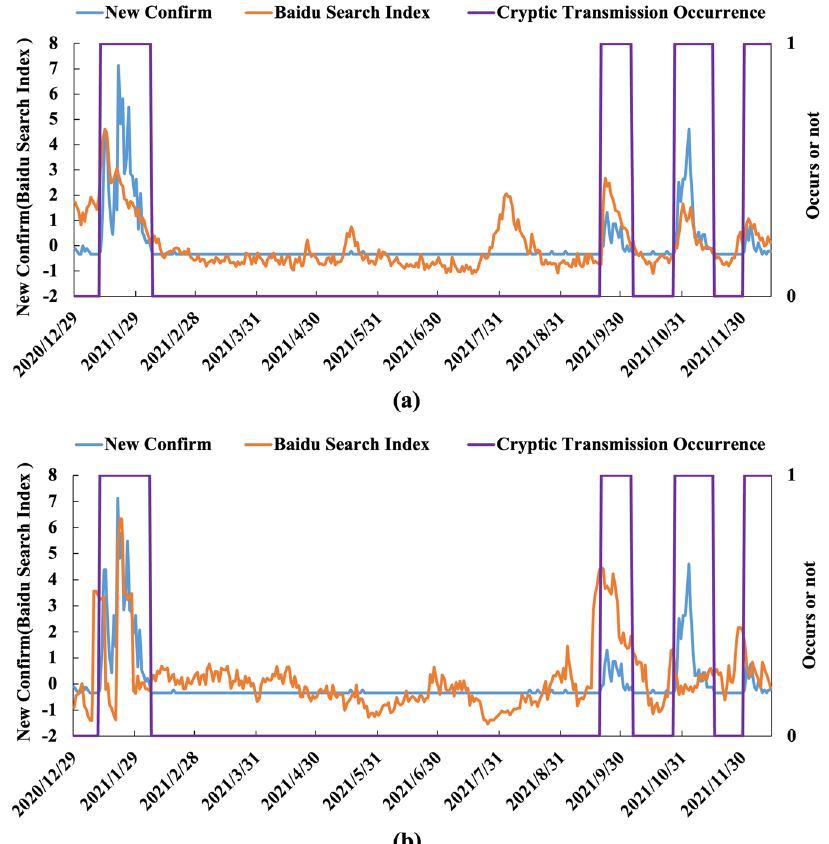
Fig. 9 The relationship between Internet retrieval data and the occurrence and development of cryptic transmission. The relationship between the retrieval data and the occurrence and development of cryptic transmission is shown. a Shows national data, and b shows a ratio (regional/national data) that expresses the concept of “ relativity ” . The left vertical axis represents the con fi rmed data and Baidu search index (after standardized processing), and the right vertical axis represents whether hidden transmission occurs (0 represents no occurrence and 1 represents occurrence). Regional Internet retrieval data are easily affected by the overall level of the country and Internet media information, so the proportion of regions in the country is used to construct the dataset.